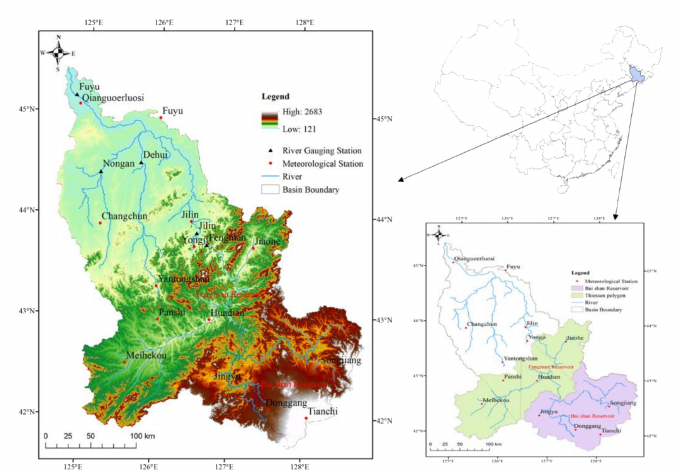
Figure 1. The river network and representative hydrological stations in the Second Songhua River Basin